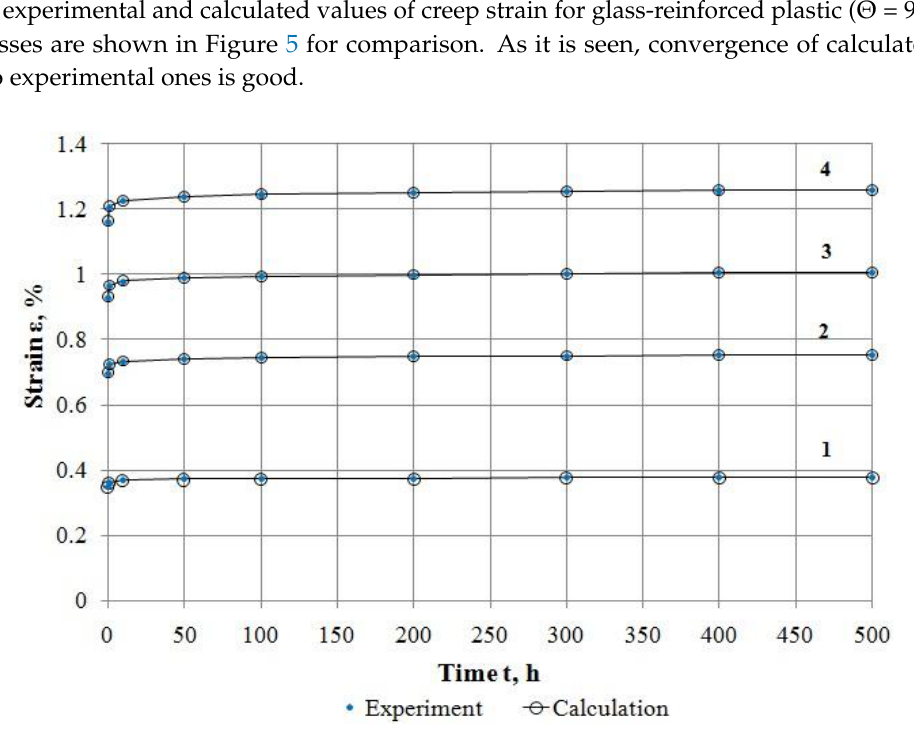
Figure 5. Creep curves of glass-reinforced plastic ( Ѳ = 90°) at various stresses: 1–104.7 MPa, 2–209.4 MPa, 3–279.2 MPa, 4–349.0 MPa.